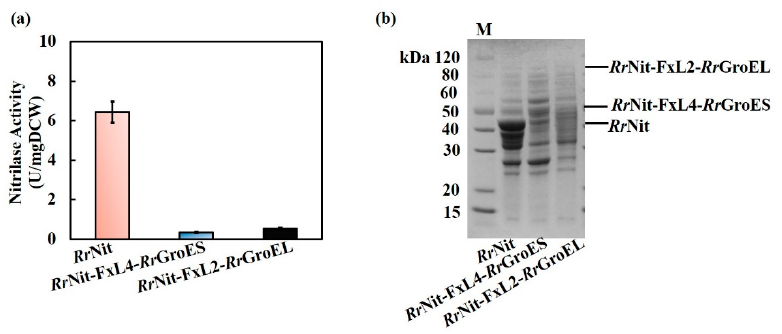
Figure 4. Nitrilase activity and SDS-PAGE results of engineered R. ruber TH3 strains. ( a ) Nitrilase activity of engineered R. ruber TH3 strains; ( b ) SDS-PAGE results of engineered R. ruber TH3 strains. M, Protein size marker; Rr Nit, supernatant of cell lysate of R. ruber TH3 (pNV18.1-P ami - Rr Nit); Rr Nit-FxL4- Rr GroES, supernatant of cell lysate of R. rube r TH3 (pNV18.1-P ami - Rr Nit-FxL4- Rr GroES);